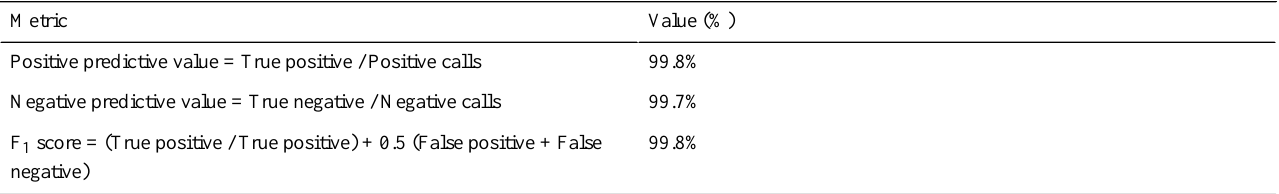
Table 3. Evaluation of the proposed model for the test set.